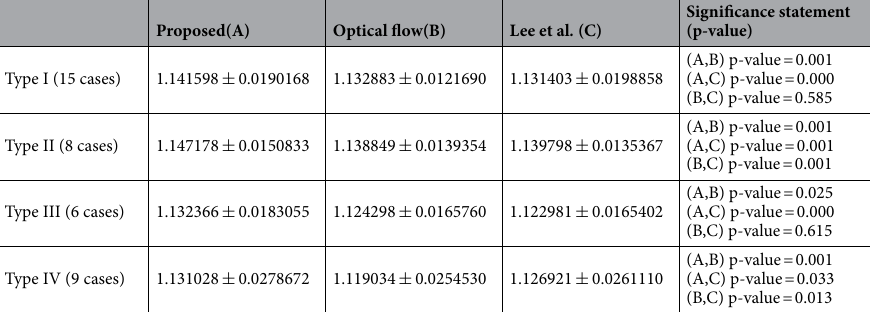
Table 4. and Fig. 9, 10, 11, 12 demonstrate that the proposed method outperformed the method developed by Lee et al. in terms of both visualization and charting results. Therefore, the proposed method achieved better image registration for images with large displacements or many flat regions. Even in difficult cases, the algorithm proposed in this study performed well.